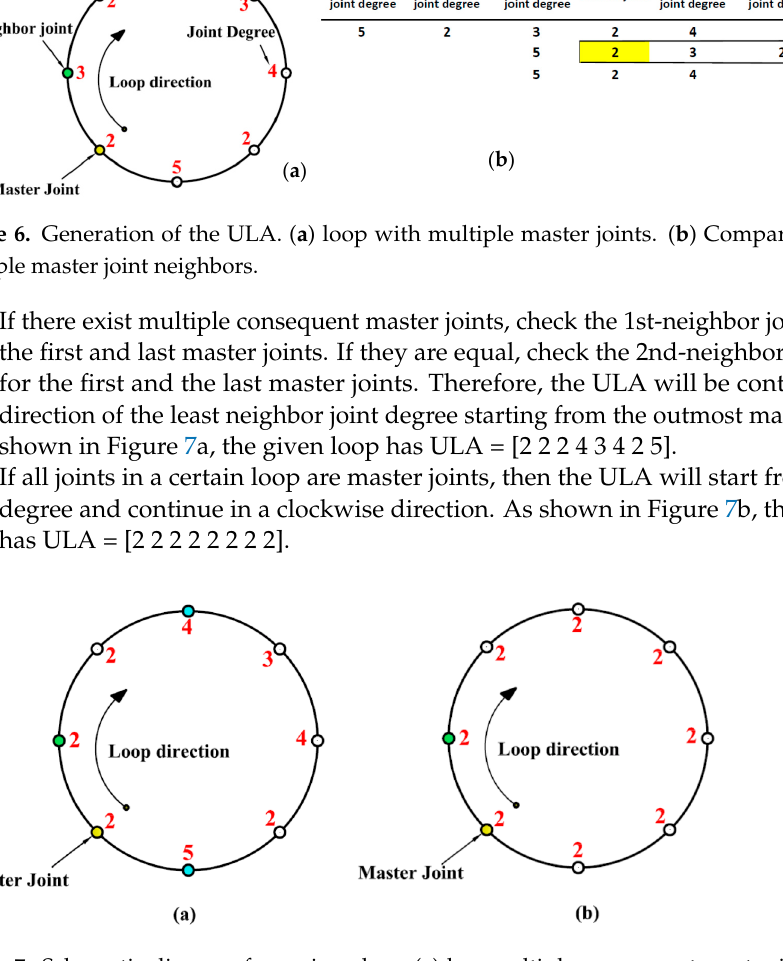
Figure 7. Schematic diagram for a given loop ( a ) has multiple consequent master joints. ( b ) has unified master joint degrees.